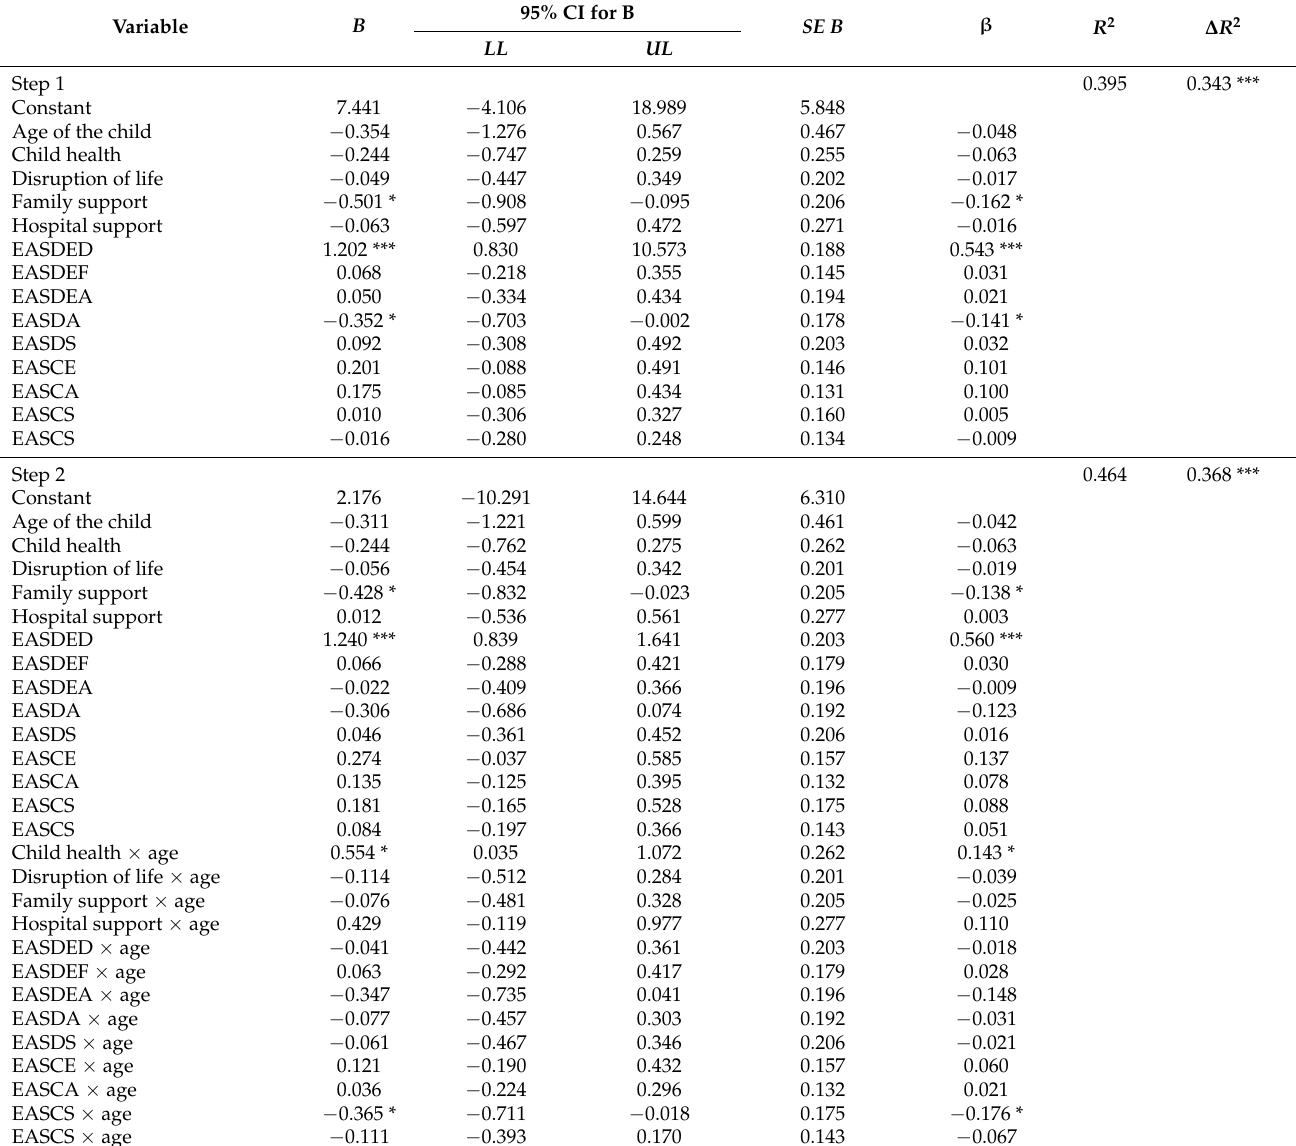
Table 5. Regression analysis with interaction effects for parental